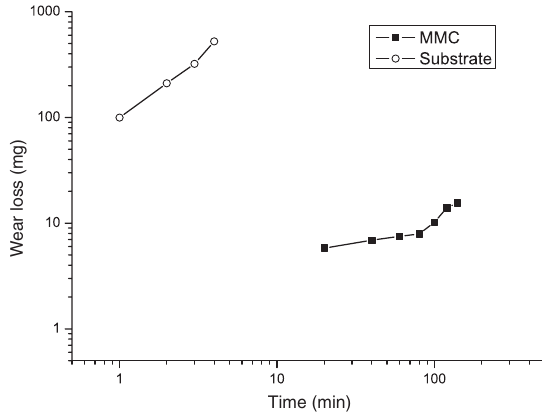
Figure 8: Wear loss of the specimen produced with H = 100 mm and the substrate versus